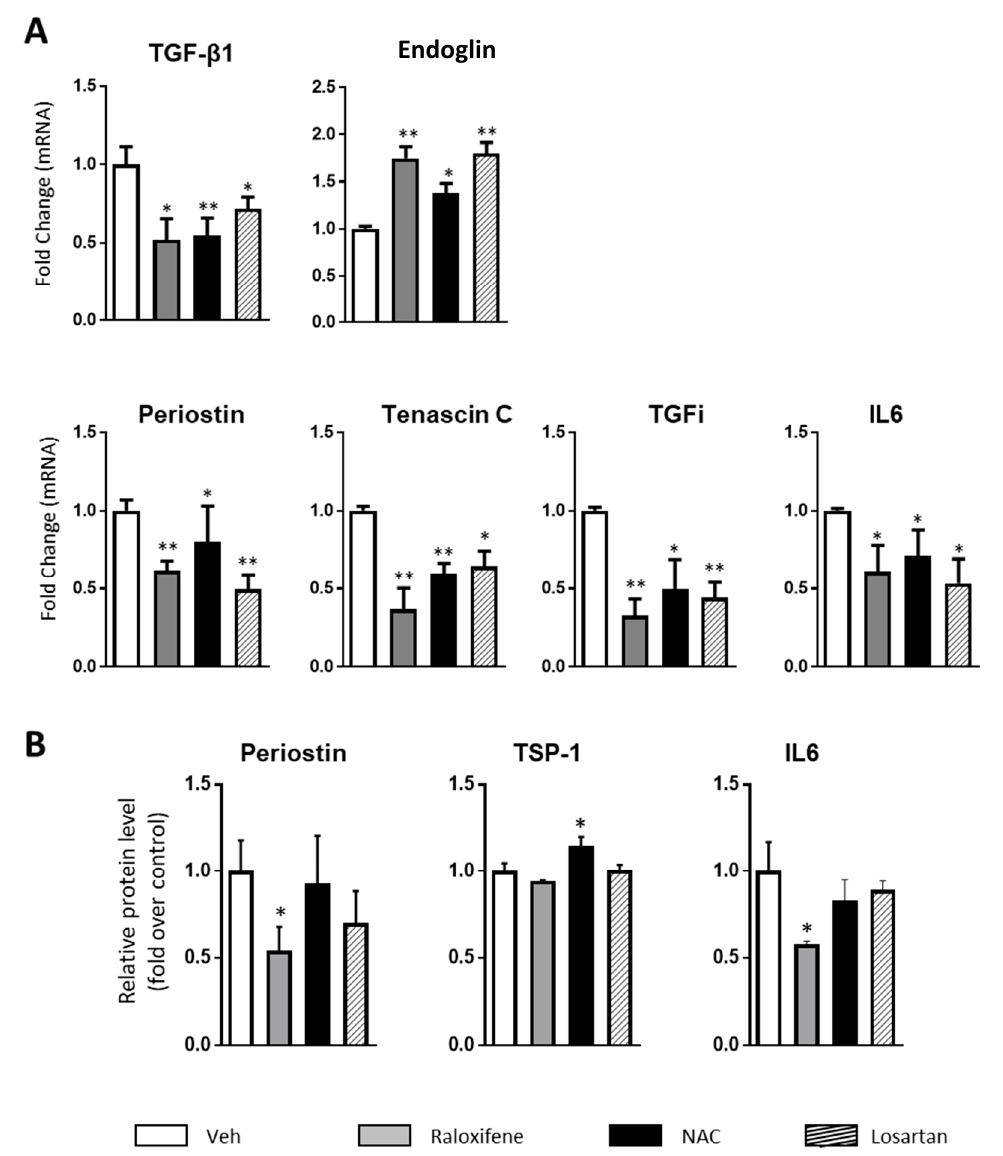
Figure 2. Raloxifene and NAC regulate fibrosis-associated biomarkers. RDEB fibroblasts from the three patients were cultured for 48 h in the presence of raloxifene (0.2 nM), NAC (100 µ M), losartan (10 µ M) or the vehicle alone (Veh). ( A ) RT-qPCR (Reverse Transcription followed by quantitative PCR) analysis of TGF- β 1 and endoglin RNA expression, and of the transcripts encoding fibrosis and inflammation associated genes. The graphs show the mean change relative to fibroblasts exposed to the vehicle alone. ( B ) Secreted periostin, TSP-1 and IL-6 protein in medium conditioned by RDEB fibroblasts treated with raloxifene, NAC or vehicle for 48 h as measured by ELISA. The graphs show the mean of change relative to fibroblasts exposed to the vehicle alone. Di ff erences were statistically significant according to the Student’s t -test: * p < 0.05; ** p < 0.01.